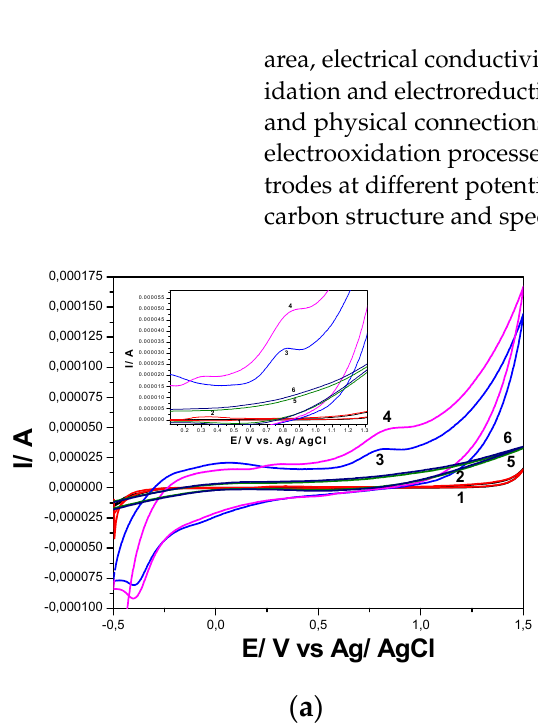
Figure 3. ( a ) Cyclic voltammograms recorded at: CNT paste electrode in 0.1 M Na 2 SO 4 supporting electrolyte (curve 1), GRQD/CNT paste electrode in 0.1 M Na 2 SO 4 supporting electrolyte (curve 3), and Cu/GRQD/CNT in 0.1 M Na 2 SO 4 supporting electrolyte (curve 5) in the presence of 5 mg · L − 1 DOX (curves 2, 4, and 6), potential scan rate: 0.05 V · s − 1 ; potential range from − 0.5 to +1.5 V/Ag/ AgCl. ( b ) Cyclic voltammograms recorded at Cu/GRQD/CNT paste electrode in: 0.1 M Na 2 SO 4 supporting electrolyte (curve 1), and 0.1 M NaOH supporting electrolyte (curve 2), potential scan rate: 0.05 V · s − 1 ; potential range from − 1 to +1.5 V/Ag/ AgCl.